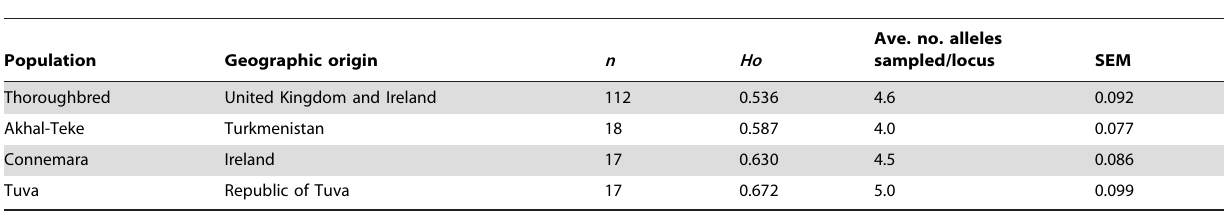
Table 1. Population genetic